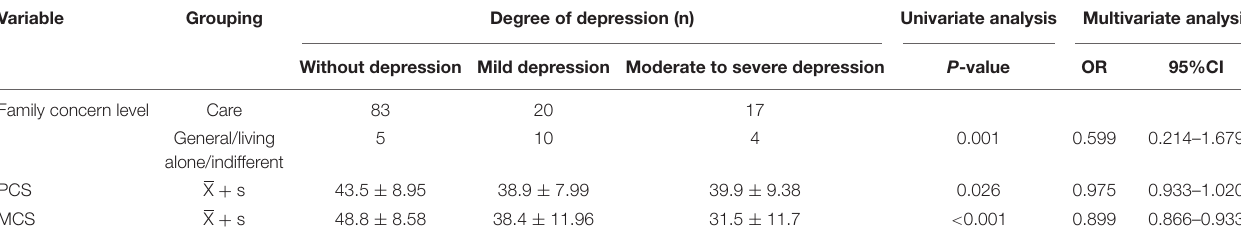
TABLE 3 | Univariate analysis and multivariate analysis on depression in patients with endometriosis.